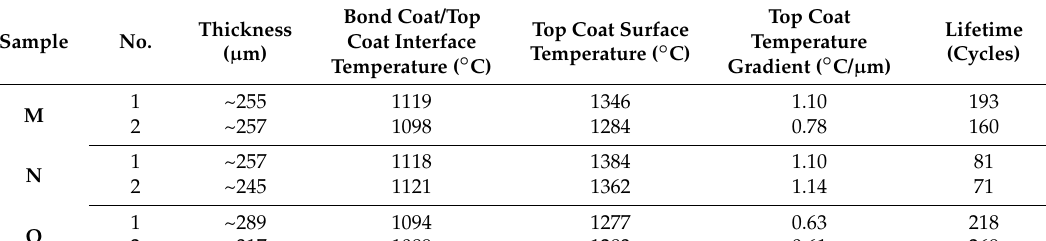
Table 2. Overview on thermally-cycled samples.